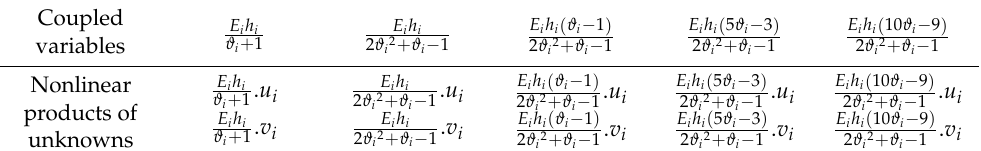
Table 1. Coupled variables and products of unknowns in the system of